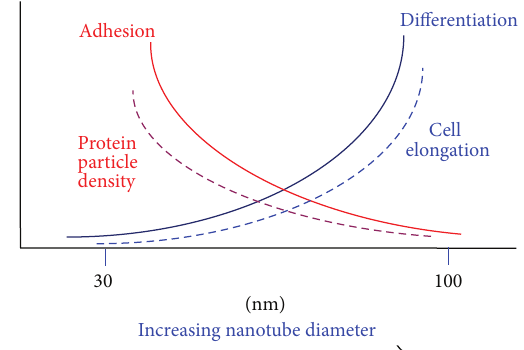
Figure 7: Schematic illustration of the overall trends of nanocue effects on cell fate and morphology. The change in cell adhesion and growth without differentiation (solid red line) has the same trend as protein particle density (broken red line), whereas that of differentiation (solid blue line) has the same trend as cell elongation (broken blue